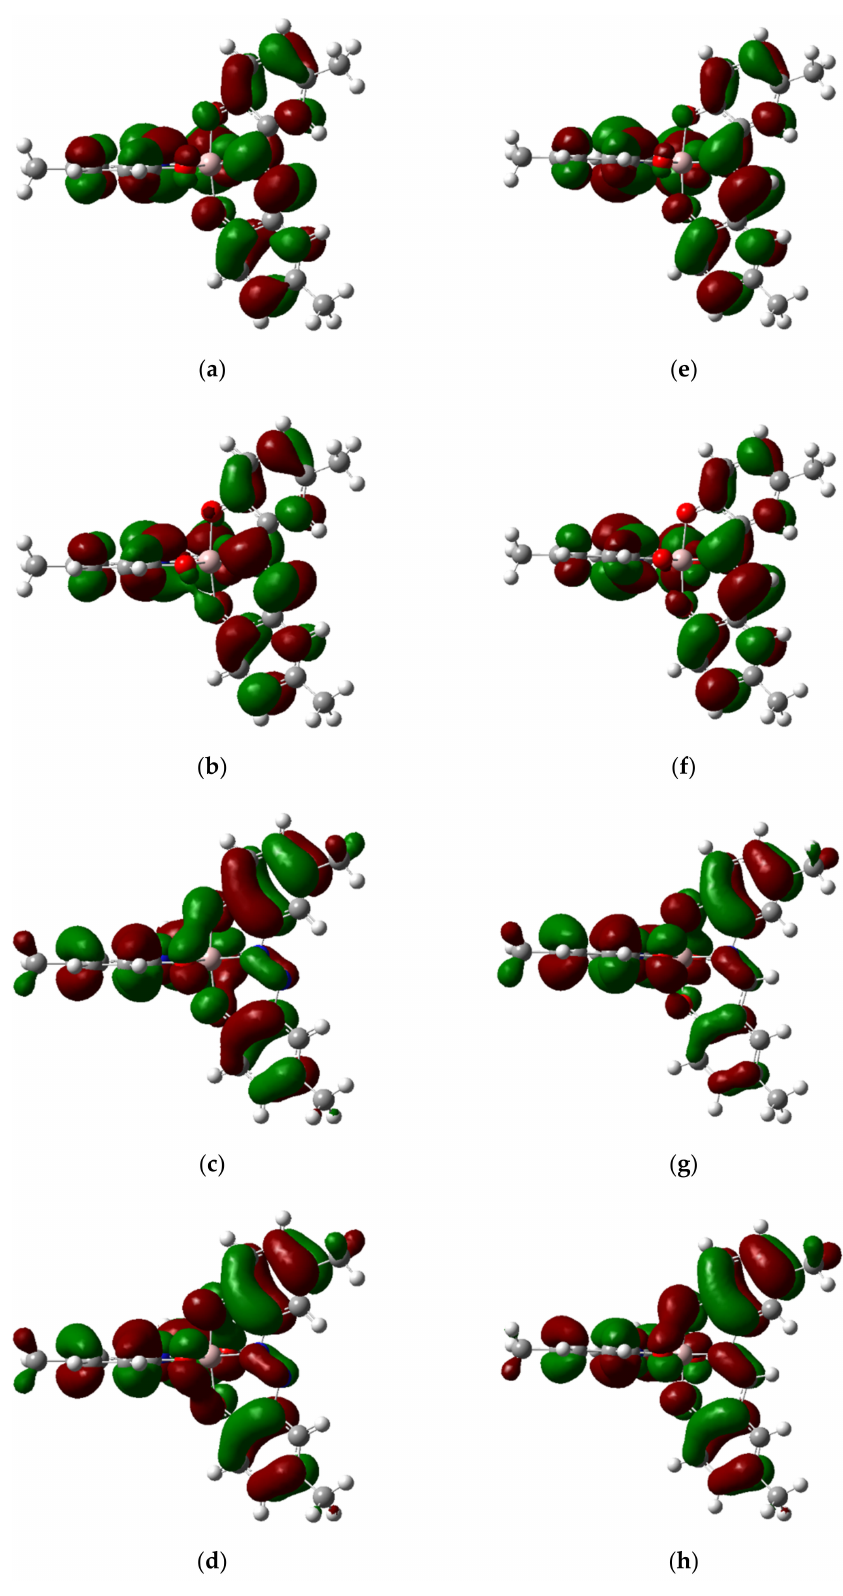
Figure 5. Molecular orbital surfaces. ( a ) The LUMO+1 of [Al III (L1 Me2 ) 2 ] − ; ( b ) The LUMO of [Al III (L1 Me2 ) 2 ] − ; ( c ) The HOMO of [Al III (L1 Me2 ) 2 ] − ; ( d ) The HOMO − 1 of [Al III (L1 Me2 ) 2 ] − ; ( e ) The LUMO+1 of [Al III (L2 Me2 ) 2 ] − ; ( f ) The LUMO of [Al III (L2 Me2 ) 2 ] − ; ( g ) The HOMO of [Al III (L2 Me2 ) 2 ] − ; ( h ) The HOMO − 1 of [Al III (L2 Me2 ) 2 ] −